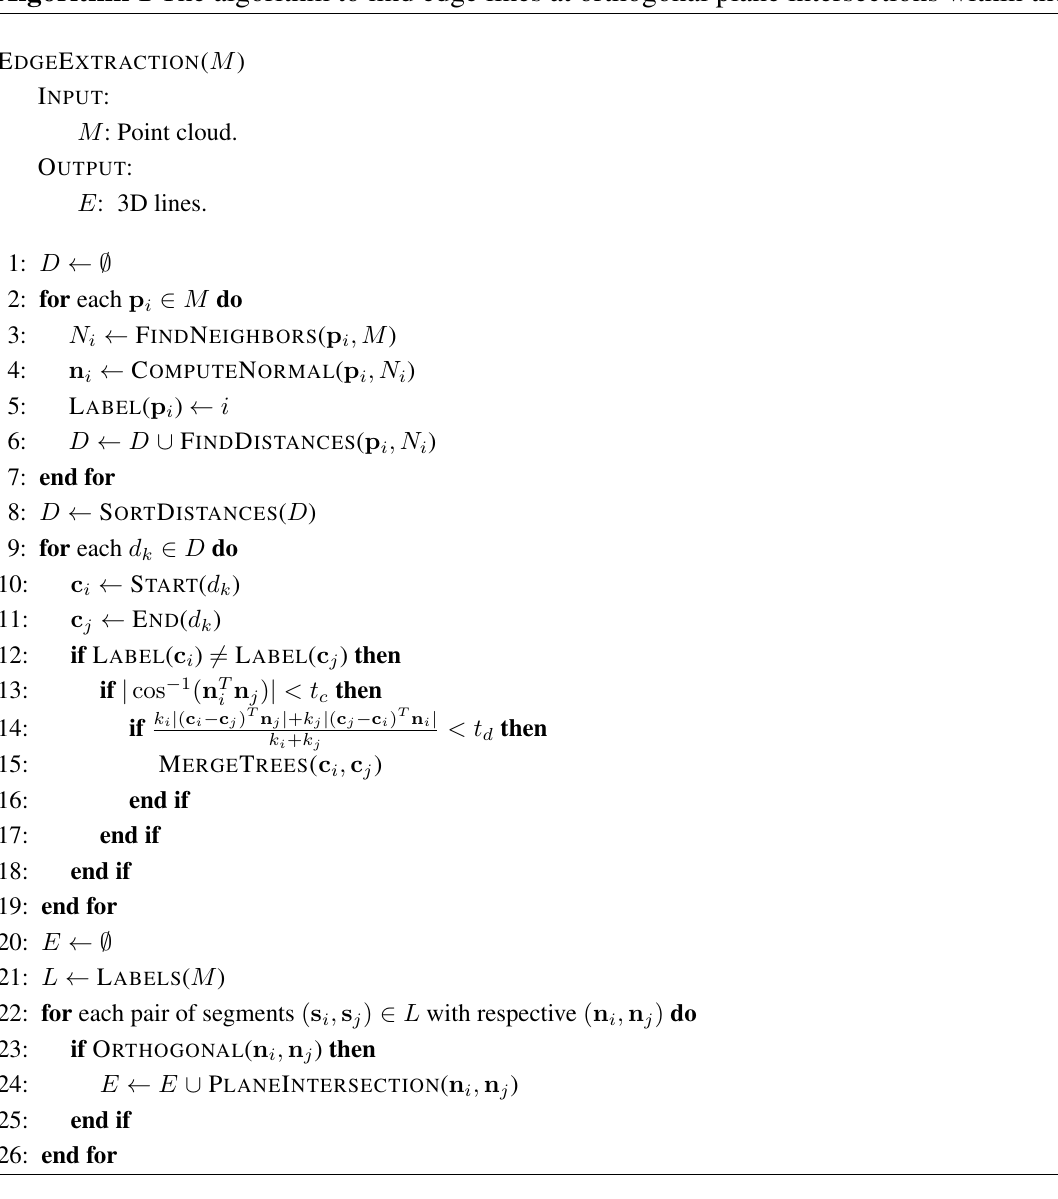
Algorithm 1 The algorithm to find edge lines at orthogonal plane intersections within the point